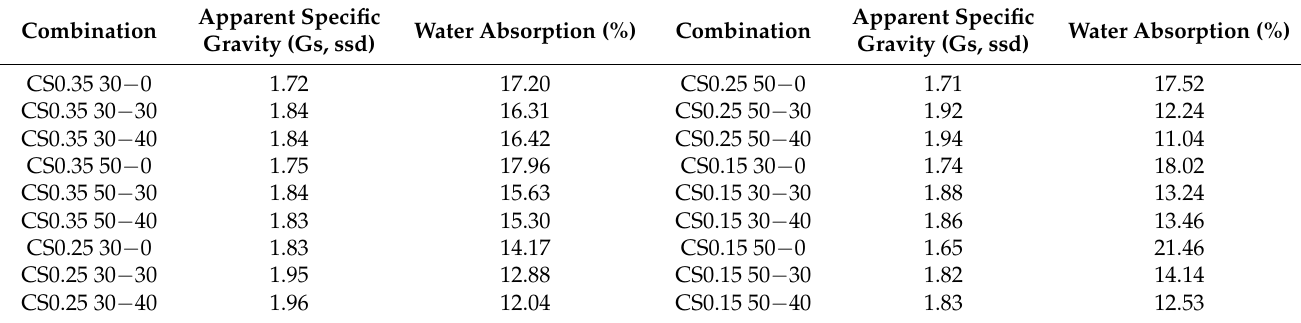
Table 5. Water absorption of EAF oxidizing slag